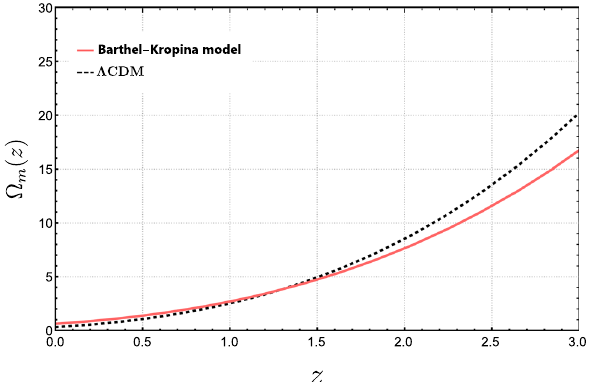
Fig. 10 The evolution of the matter density parameter as a function of the redshift z